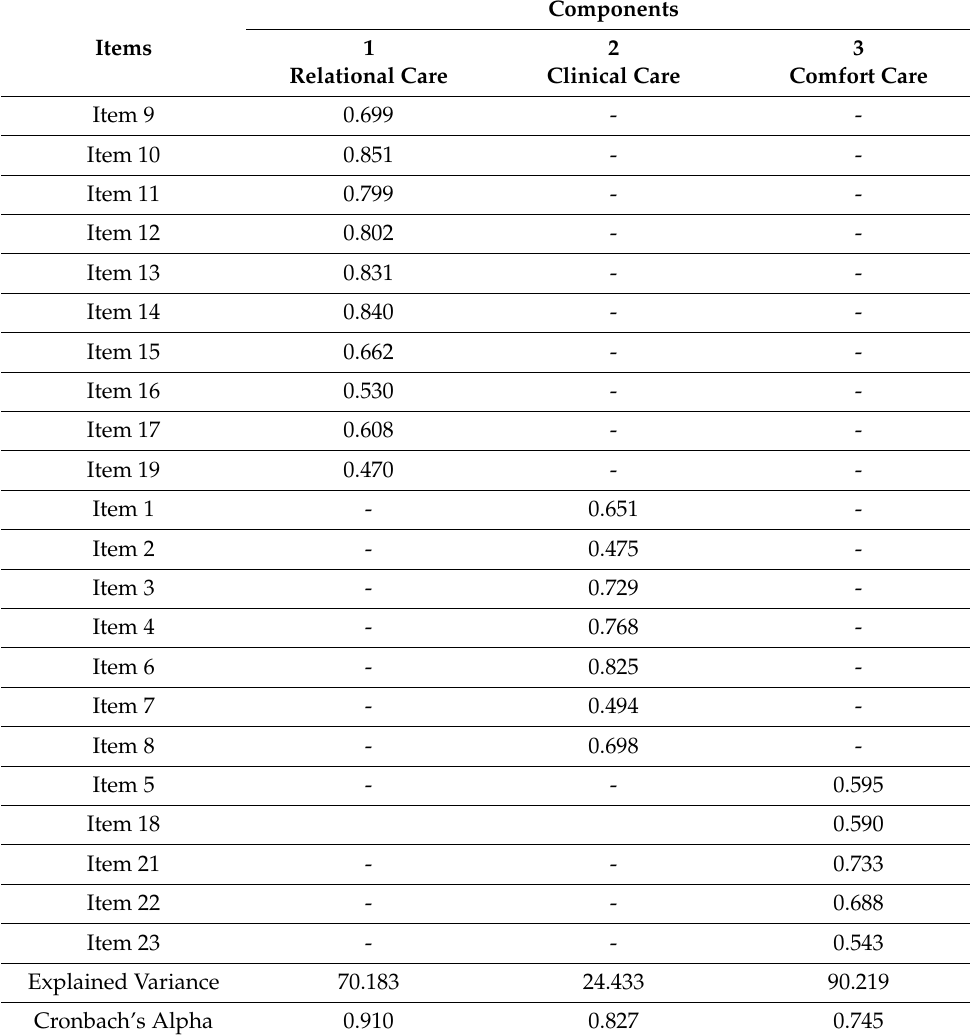
Table 1. Components of the nurse-patient interaction scale 22-PT.